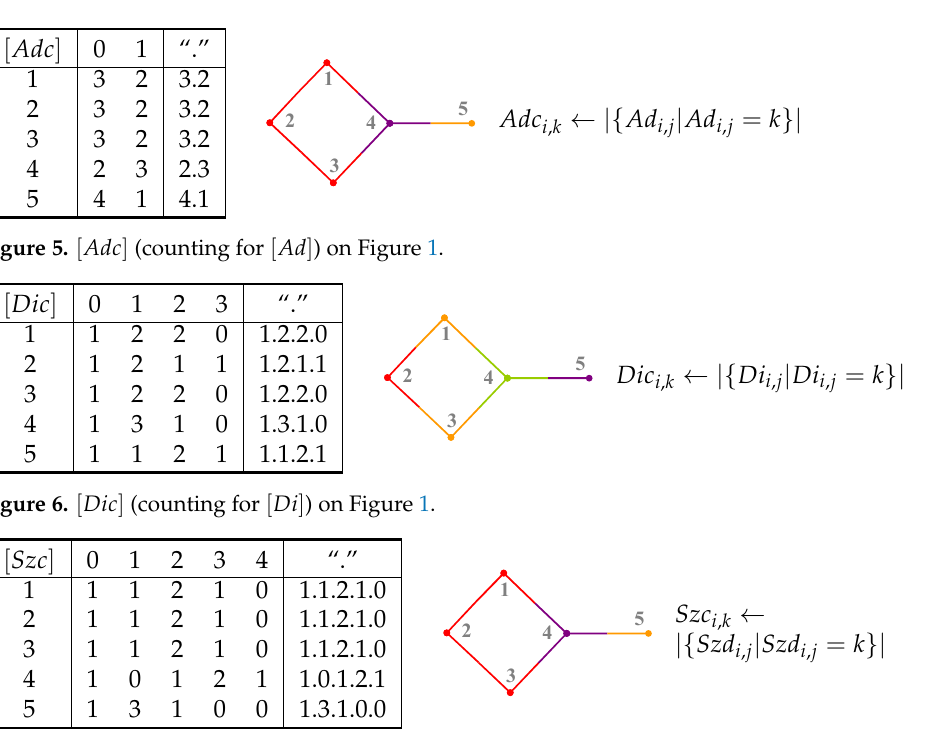
Figure 7. [Szc] (counting for [ Szd ] ) on Figure 1.